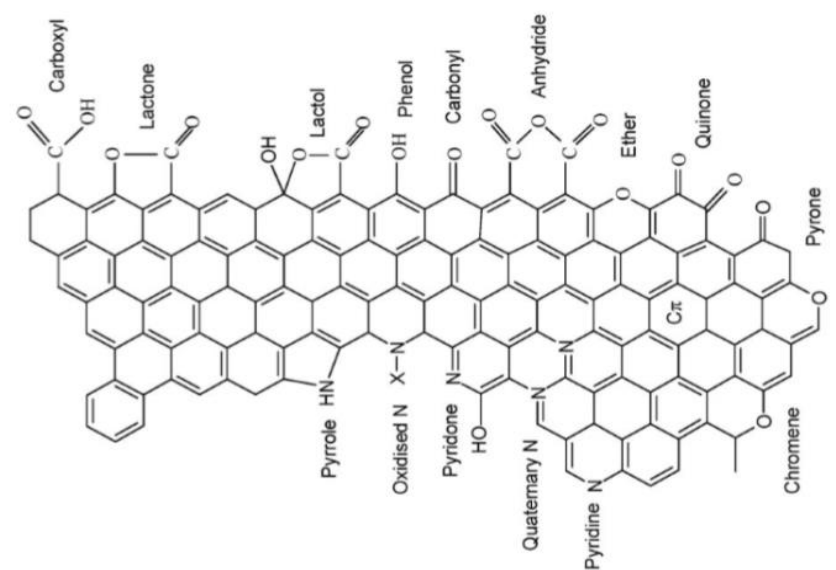
Figure 3. Possible functional groups on carbon surfaces (Reproduced by permission from Elsevier from Ref. [291]).